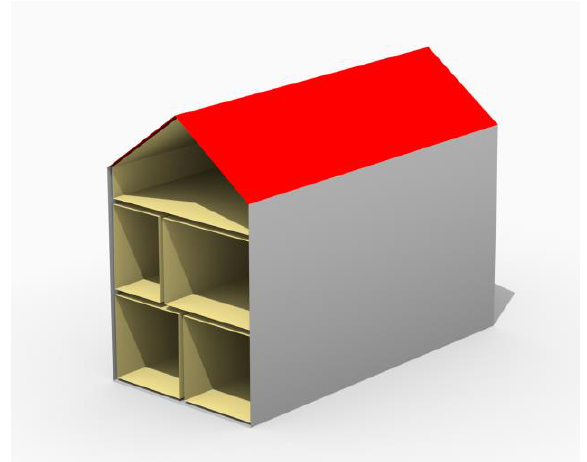
Figure 3 . . LoD2 representation of a building (exterior) and of rooms.